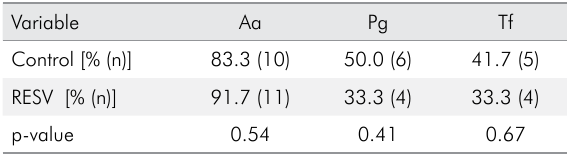
Table 2. Percentage (%) and absolute number (n) of sites positive for the periodontal pathogens Aggregatibacter actinomycetemcomitans Aa, Porphyromonas gingivalis Pg and Tannerella forsythia Tf in ligatures from the control and RESV